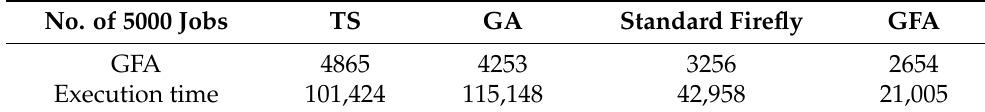
Table 6. Makespan and Execution times for Typical Workloads.